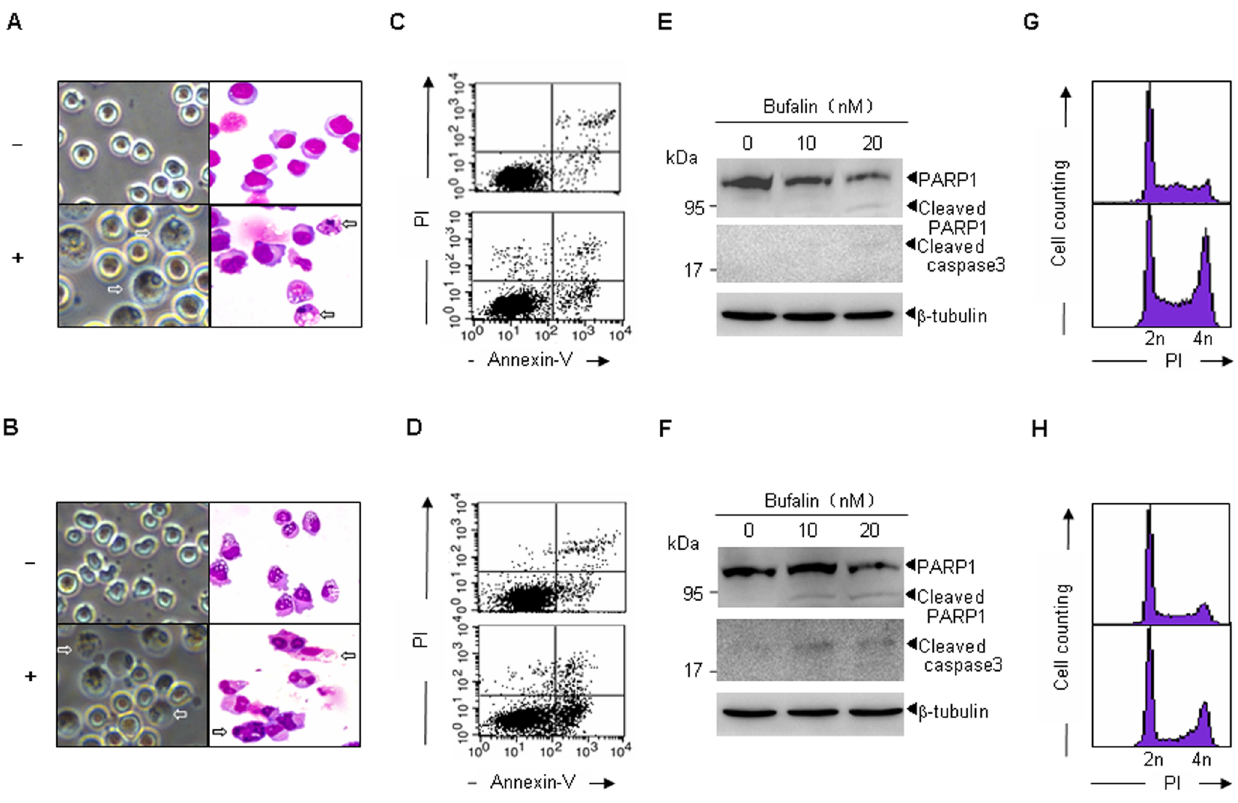
Figure 4. Bufalin induces apoptosis and cell cycle arrest in MM cells. H929 (A, C, E, G) and U266 (B, D, F, H) cells were treated with or without 20 nM bufalin for 48 h, and cell morphology (A–B) was monitored by phase contrast microscope (40 6 , left) or Wright’s staining (100 6 , right). Arrowheads indicated apoptotic cells. Annexin-V-positive cells (C–D) were quantified by flow cytometry analysis. Indicated proteins were analyzed by western blot analysis (E–F). Cell cycle distribution was determined by flow cytometry analysis of DNA content (G–H). Each experiment was performed in triplicate and repeated at least three times.